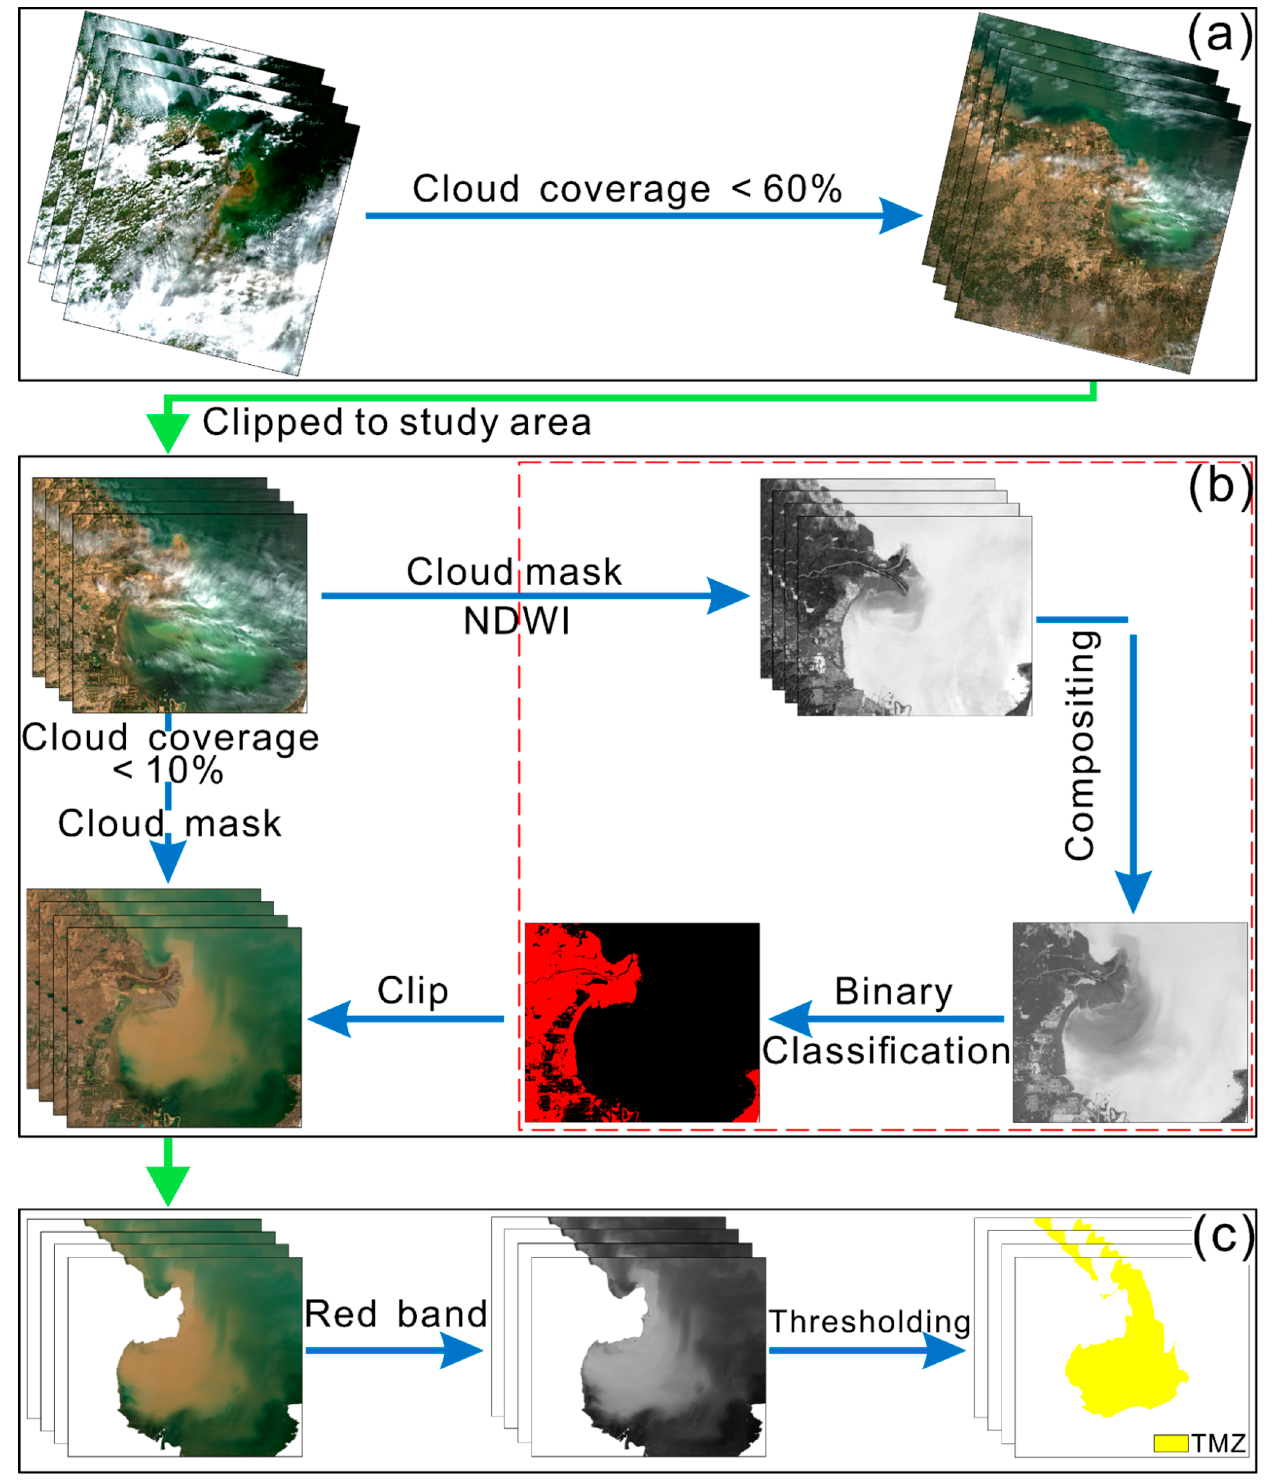
Figure 3. Flowchart of time series TMZ mapping during the period 1984–2021 in the Yellow River estuary. ( a ) Preliminary images filtration; ( b ) land–water boundary generation and further cloud filtration; ( c ) TMZ mapping based on red band thresholding. All these processes were conducted on GEE.